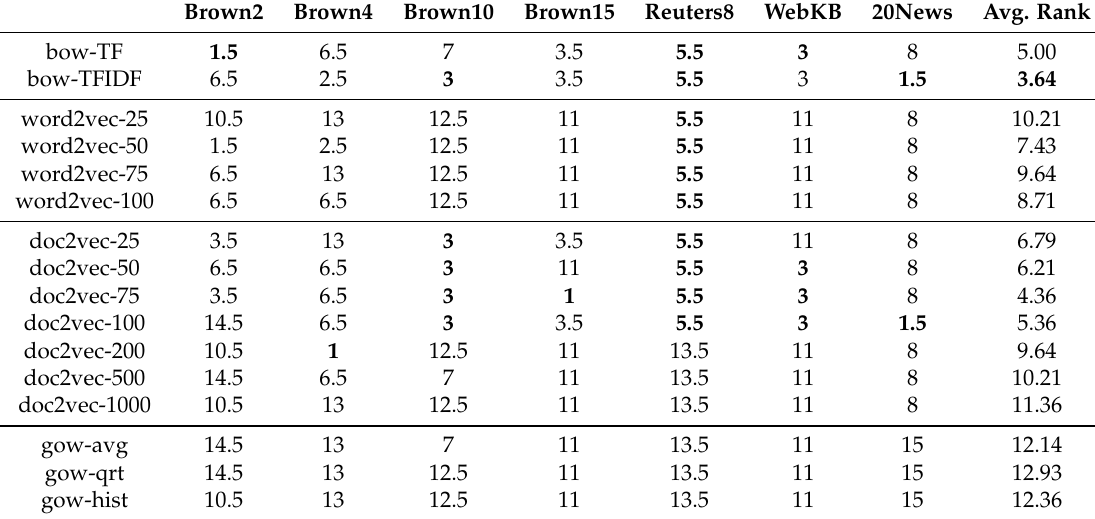
Table A2. Multi-objective ranking of the 16 variants of the three document representation models by document classification task with respect to recall. The last column reports the average rankings over the seven tasks. The top-ranked models in each column are shown in